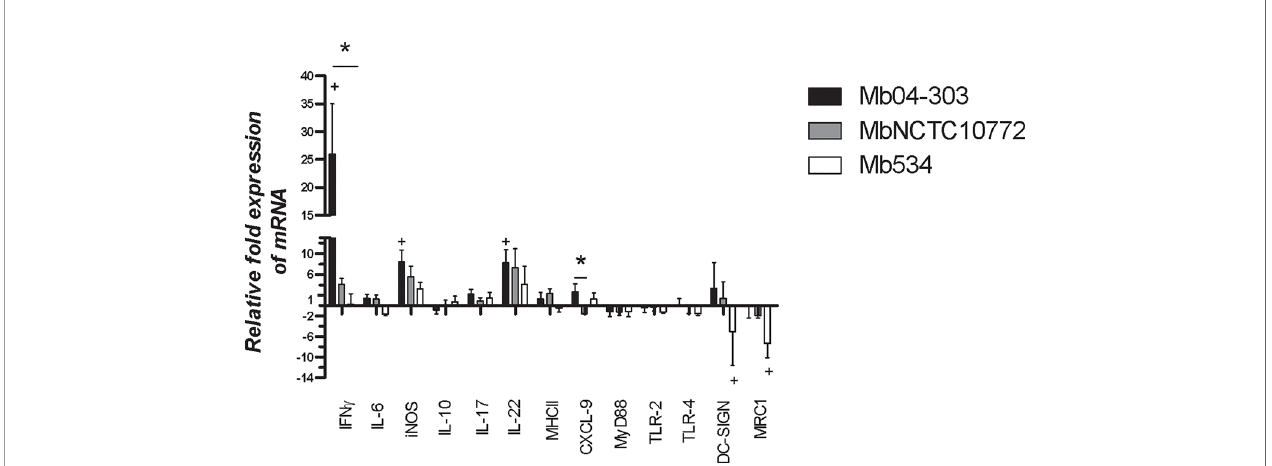
FIGURE 1 | Expression of immune mediatorsassessed byRT-qPCR inco-cultures from fi ve to seven different calves (N=5-7)infected with M. bovis strains (MOI=5).After infection,bovine macrophages were incubatedwith autologous lymphocytes (1:10)for 16 h. Total RNA was extracted using Trizol standard protocols. Relative expression of each immune mediator was analyzed using gapdh as a reference gene andthe non-infectedcondition as calibrator(barsrepresent mean values andwhiskers SEM). + indicates signi fi cant upregulation inrelation to the non-infected condition (p<0.05) analyzed by pair wise fi xed reallocation randomization test (https://www.infostat.com.ar/ index.php?mod=page&id=34&lang=en). *indicates signi fi cant differences between co-cultures infected with different strains (p<0.05)determinedby Friedman